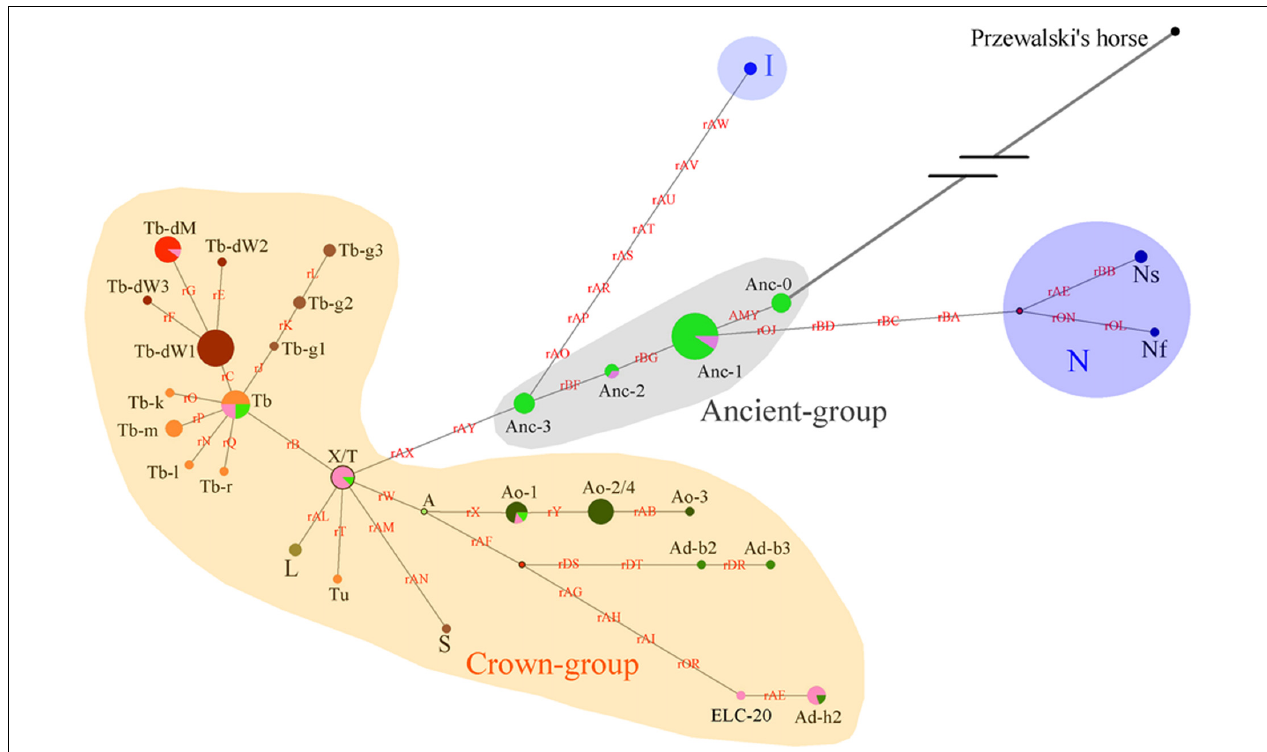
FIGURE 4 | Network constructed with 51 Y-chromosome segregating sites. Brown characters on the lines indicate mutations on single ECAY genes/fragments copies. Black characters near to the pie charts represent the different breeds’ clusters. Crown-group was firstly defined by Wallner et al. (2017) and most of the horse breeds from Europe in our study are included in this group. Sizes of the pie charts are proportional to number of individuals clustered in them. Green and pink pies in Ancient-group refer to horse breeds from South and North China, respectively. Red dots are median vectors.